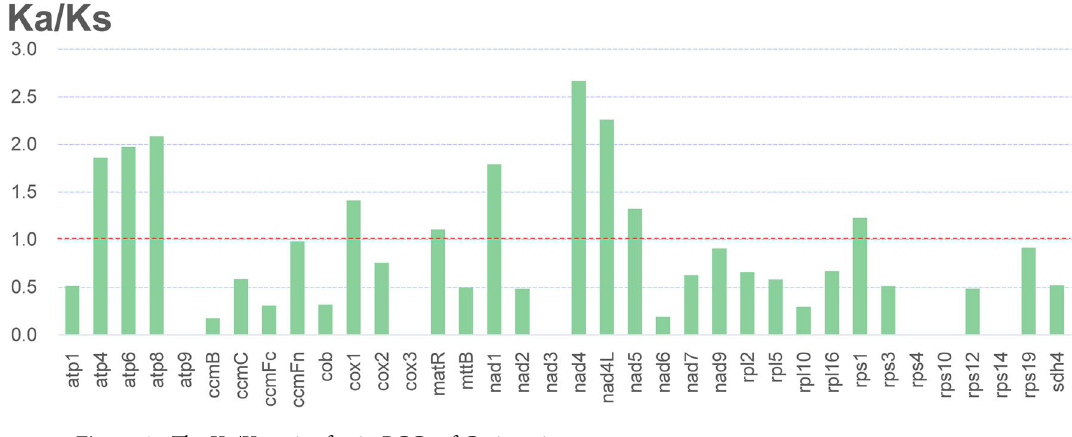
Figure 4. The Ka/Ks ratios for 37 PCGs of G.